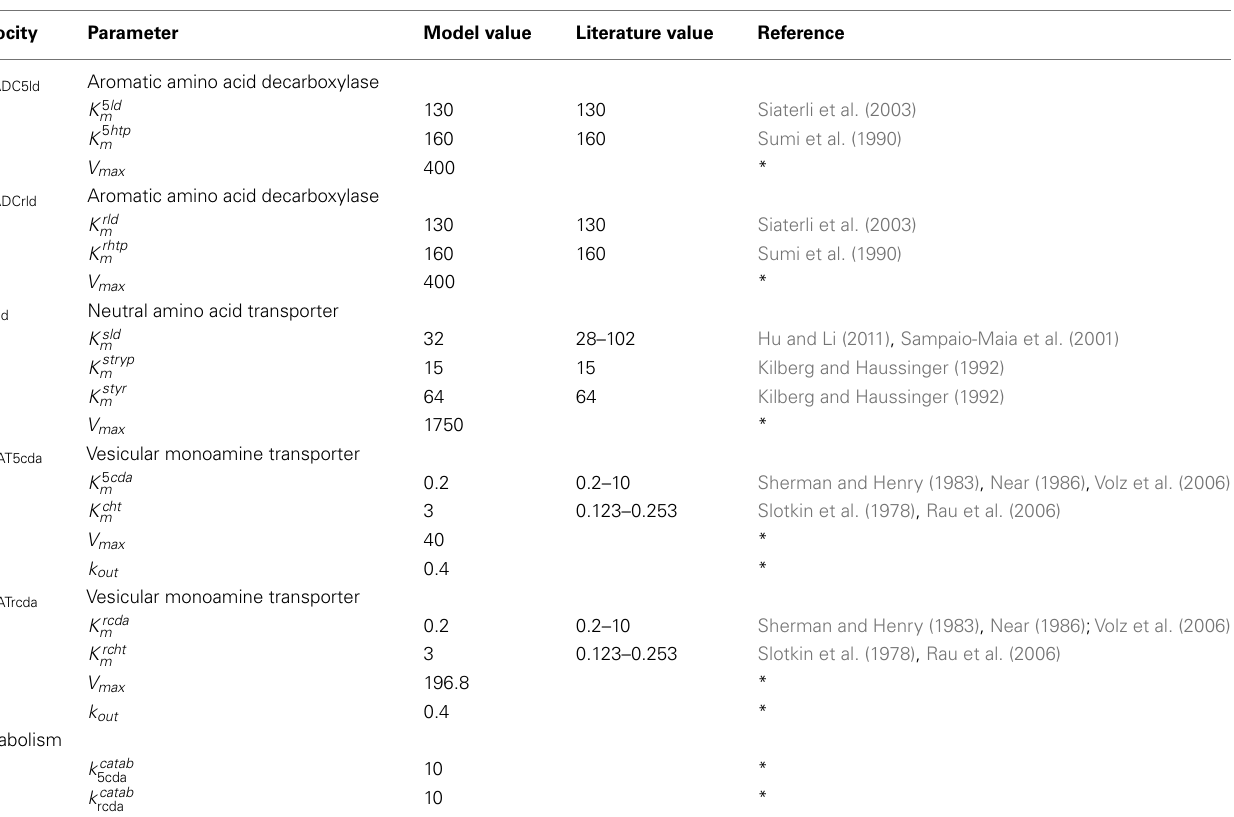
TableA5 | Kinetic parameters ( µ M, µ M/h, /h): LD and DA in the 5HT neuron. Velocity